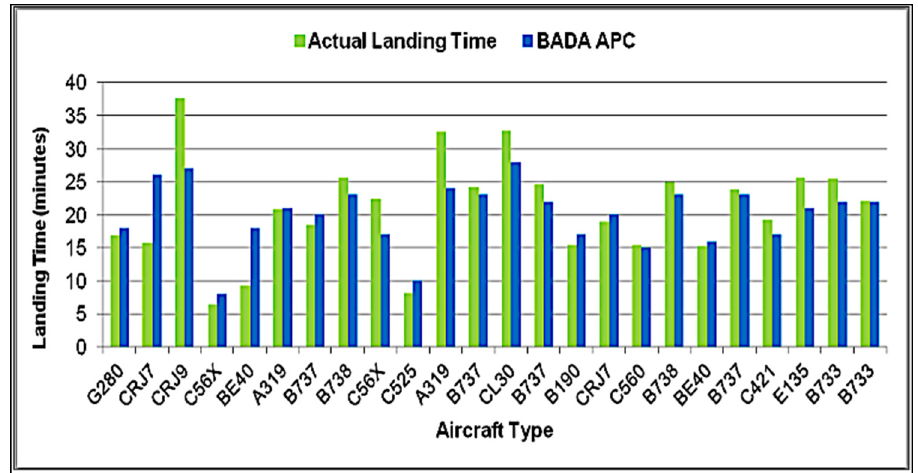
Figure 4. Evaluation of aircraft landing times with CDA at BNA airport.